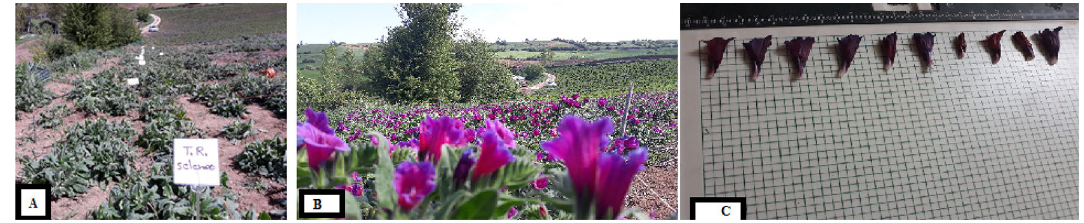
Figure 1. Echium amoenum treatead with Selenate (before flowering) ( A ); (after flowering) ( B ); Sample of flower treated with different selenium sources ( C